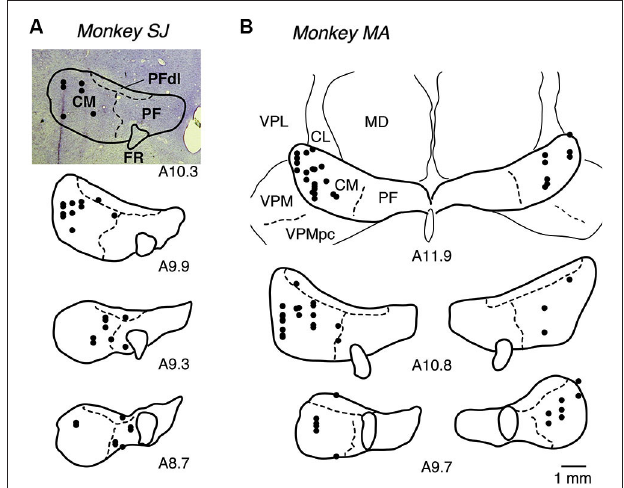
FIGURE 2 | Recording sites of LLF neurons . (A, B) Locations of recording sites for monkeys SJ and MA, respectively. Locations of recorded neurons are plotted in black dots on photograph of coronal Nissl-stained sections (A10.3) or on drawings of borders of nucleus, positioned from anterior to posterior as from top to bottom. A10.3 represents anterior 10.3 mm in Horsley-Clarke coordinates (i.e., distance from the plane having external auditory meatus). CL, centrolateral nucleus; FR, fasciculus retroflexus; MD, mediodorsal nucleus; PF, parafascicular nucleus; PFdl, dorsolateral parafascicular nucleus; VPL, ventral posterolateral nucleus; VPM, ventral posteromedial nucleus; VPMpc, ventral posteromedial nucleus pars